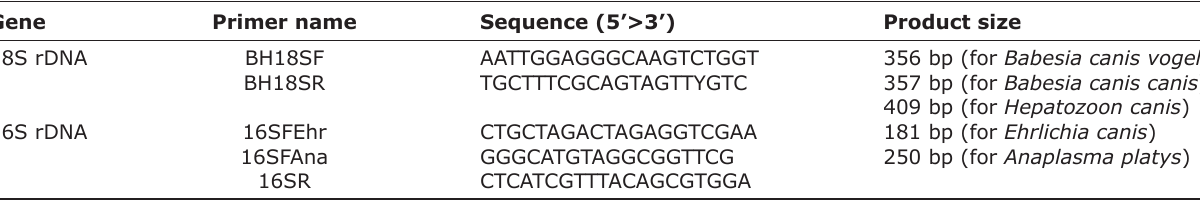
Table-1: Targeted genes and list of new primers used in this study.